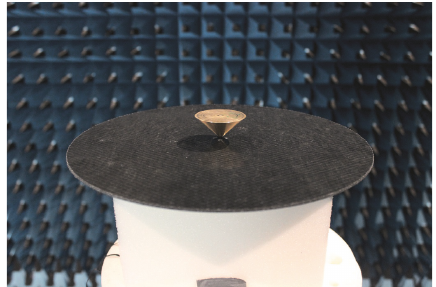
Figure 14: Conical monopole antenna on the shred-CFRP ground plane. The antenna is placed on a Rohacell column on an azimuth rotary stage inside the university’s anechoic